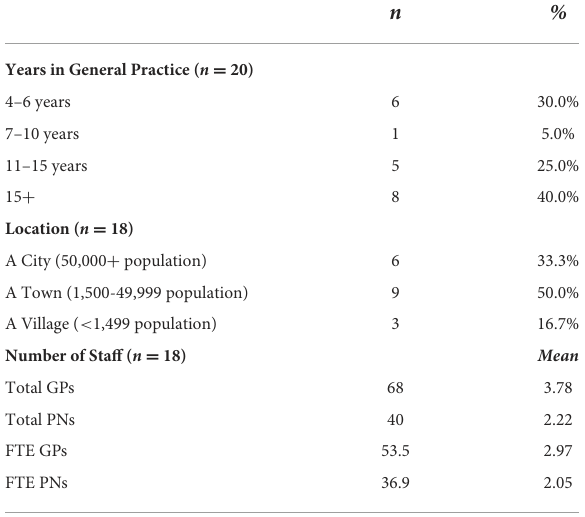
TABLE 1 Demographic profile of respondents.